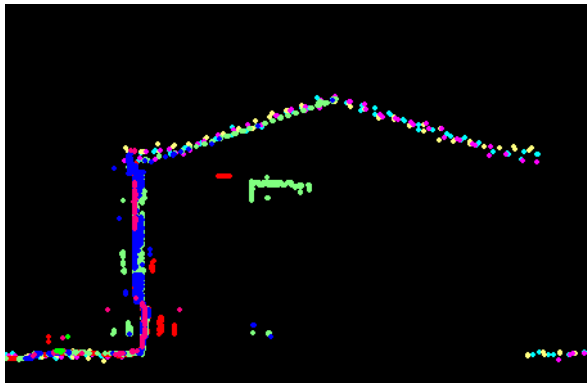
Figure 6: A cross section of a gable roof and a ground segment demonstrating the alignment between the airborne and terrestrial data